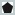
Distribution of traditional horse breeds and sampling sites in Bhutan.⋆ Sharta, ♦ Yuta and ⬟ Boeta.